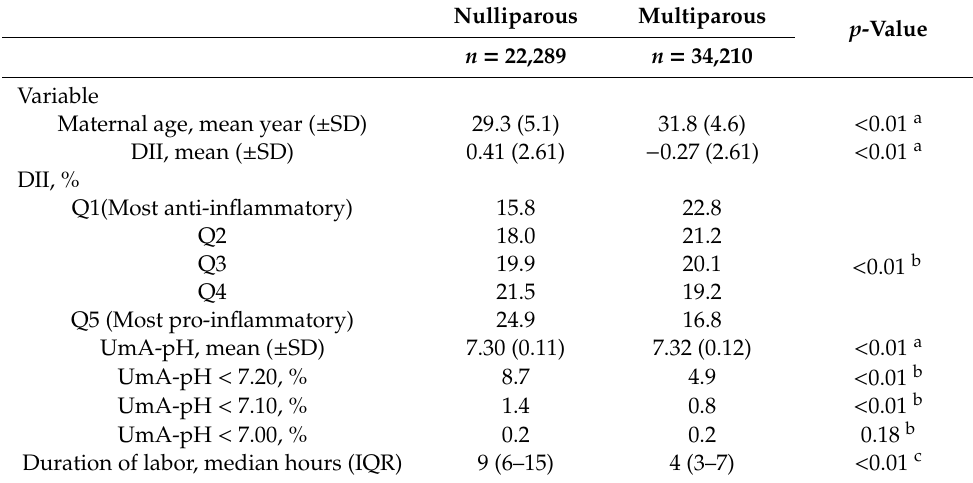
Table 2. Comparison of DII and obstetrics characteristics among